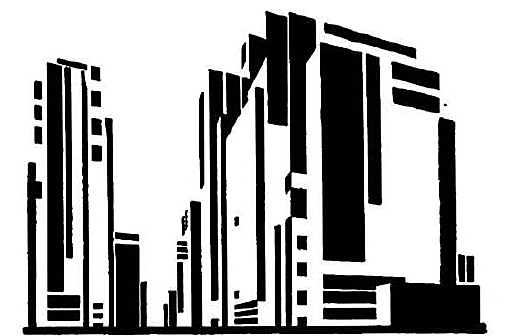
fig. 3. Drawing no. 126 in Fundamentals of Contemporary Architecture (Chernikhov 1930: 77). Note: Through the use of unconnected planes, Chernikhov sets in motion the viewer’s ability to perceptually complete a three- dimensional shape, which is then recognized as a